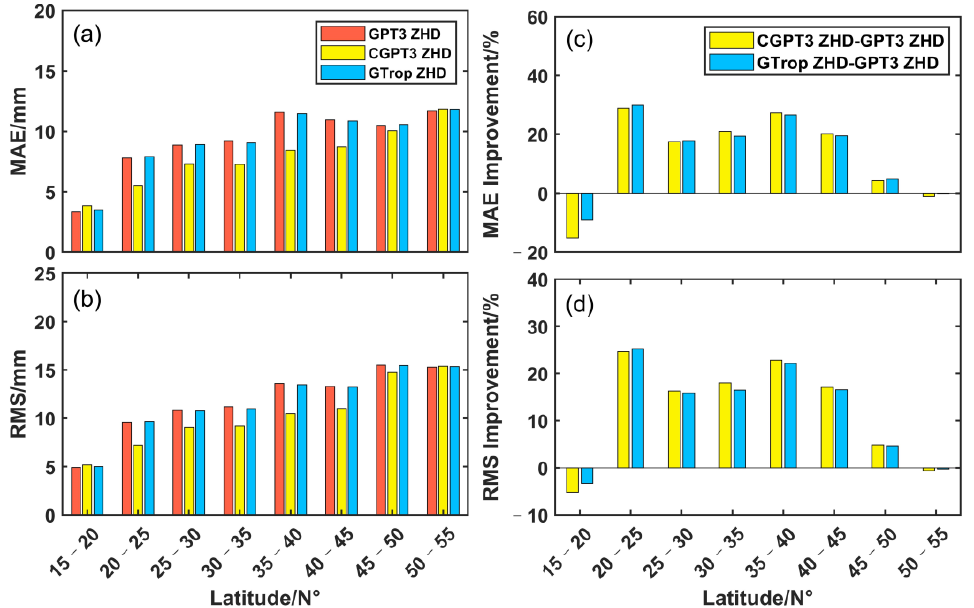
Figure 5. Variation of MAE and RMS with latitude ( a , b ) and improvement rates of the absolute values of MAE and RMS ( c , d ) of ZHD derived from the three models. values of MAE and RMS ( c , d ) of ZHD derived from the three